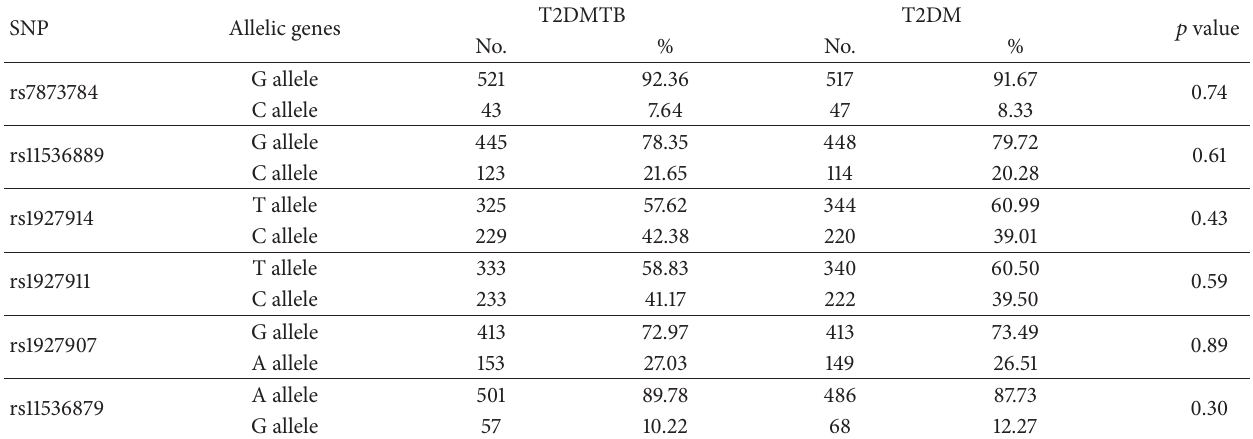
Table 4: Distributions of allelic genes of SNPs between patients with T2DMTB and patients with